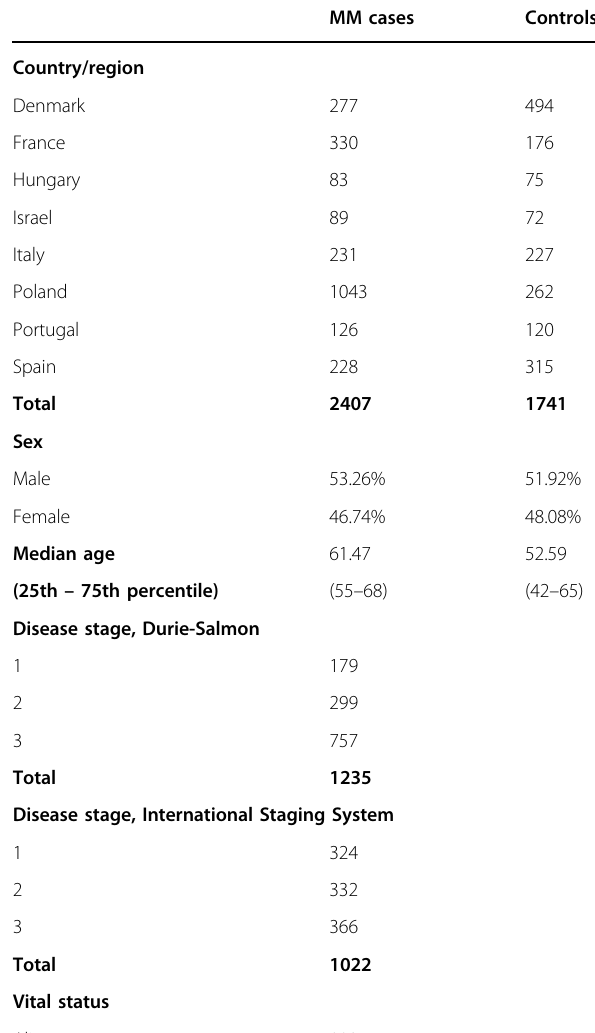
Table 1 Summary of the study